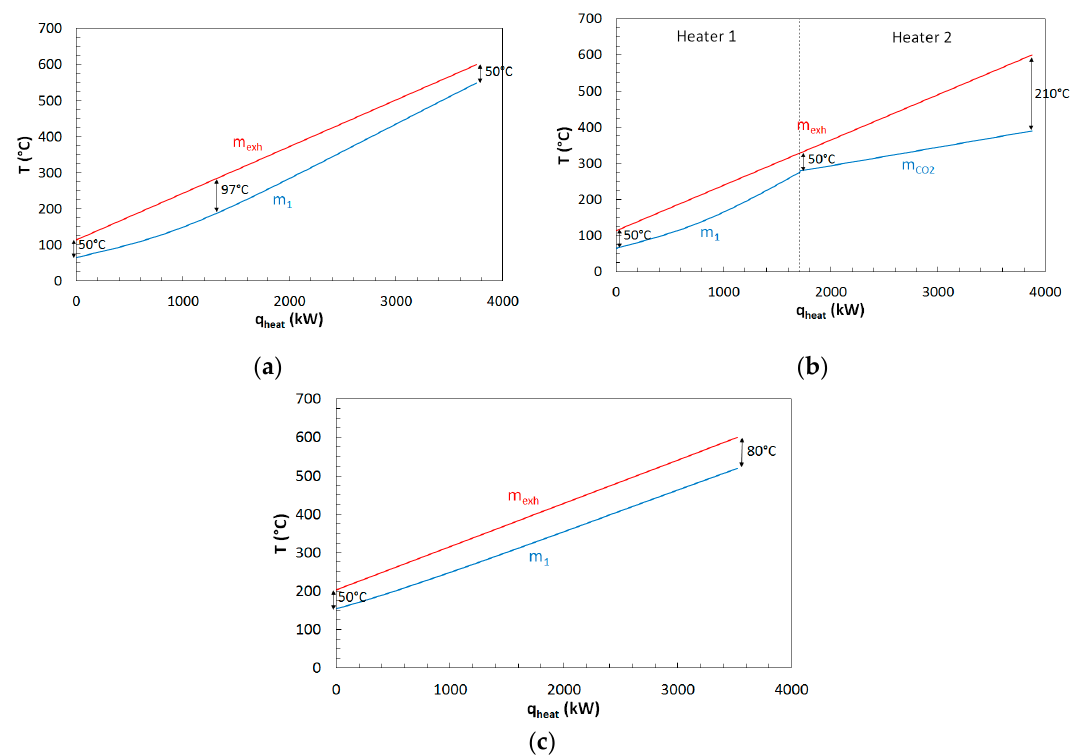
Figure 17. Temperature–heat load diagram in the heater/s of the s-CO 2 power cycles: ( a ) Single flow split with dual expansion; ( b ) partial heating; ( c ) dual recuperated.